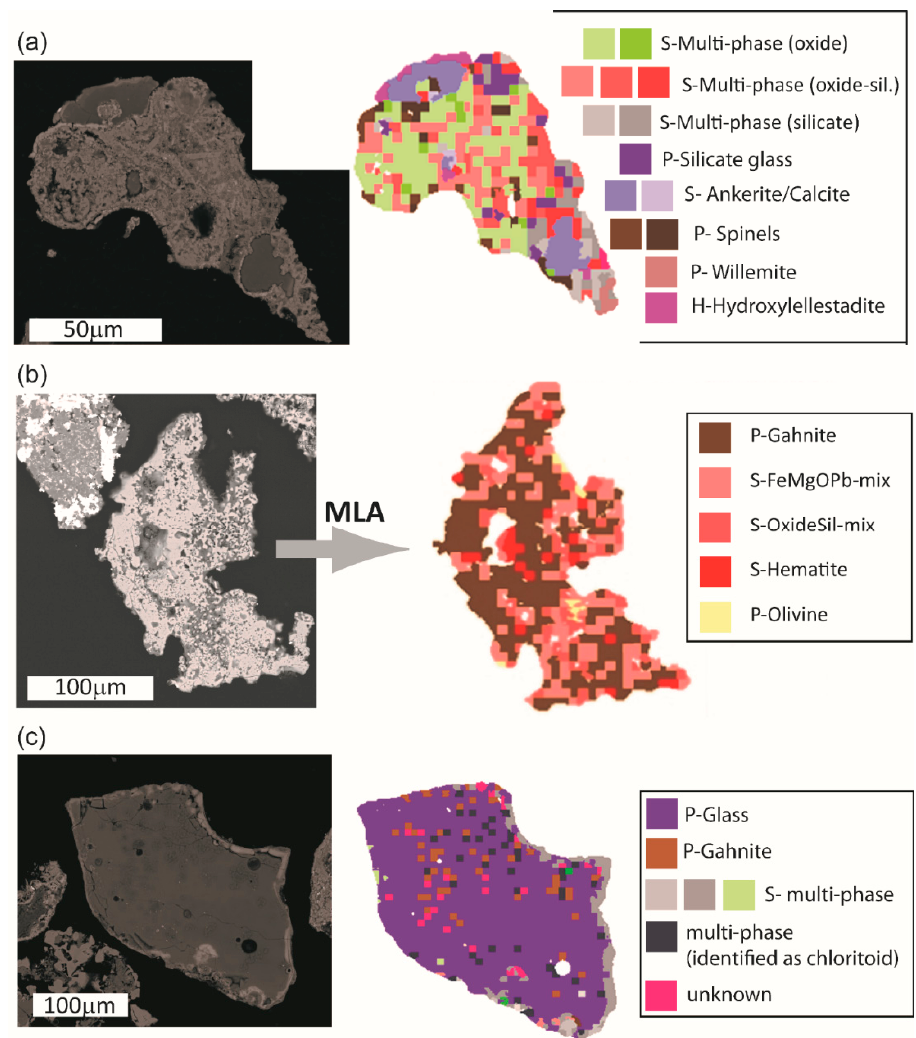
Figure 2. ( a – c ) Back-scattered electron (BSE) image of a slag phases from horizon C and complementary EDX spectral maps (GXMAP) supplied by the automated Mineral Liberation Analysis (MLA). P: Primary phase, S: Secondary phase (according to the classification based on BSE observations and EDS analyses).